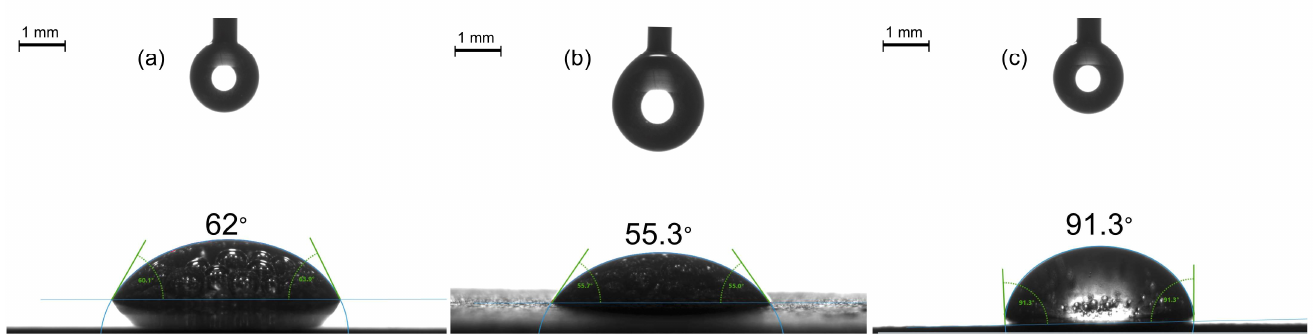
Figure 4. Contact angles of SBF on the surface of: ( a ) polished ZM21, ( b ) TNC-coated ZM21, and ( c ) HA-TNC-coated ZM21 samples.